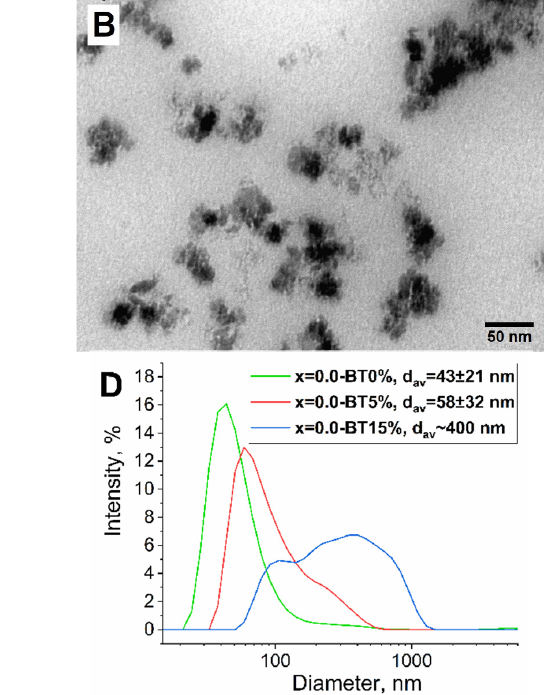
Figure 5. XRD ( A ) and EDX ( B ) study of the obtained x = 0.0-BT5%. The initial mass ratio of the magnetic phase to the ferroelectric phase was 1 to 2.5. It was chosen because the magnetic phase should be surrounded by barium titanate to gain a higher ME effect, otherwise the presence of interfacial magnetic connections leads to an increase in the electric conductivity of the whole material (ferrites are semiconductors) and a decrease in ME effect. On the other hand, the larger amount of ferroelectric phase leads to less interfacial connections between magnetic and ferroelectric phases and therefore the lower ME effect. Thus, maintaining the optimal ratio of phases is necessary. For this reason, extra samples (x = 0.0-BT 1–4) with 1 to 4 magnetic to ferroelectric phases were synthesized and studied by TEM, XRD, and DLS analyses. According to TEM, the